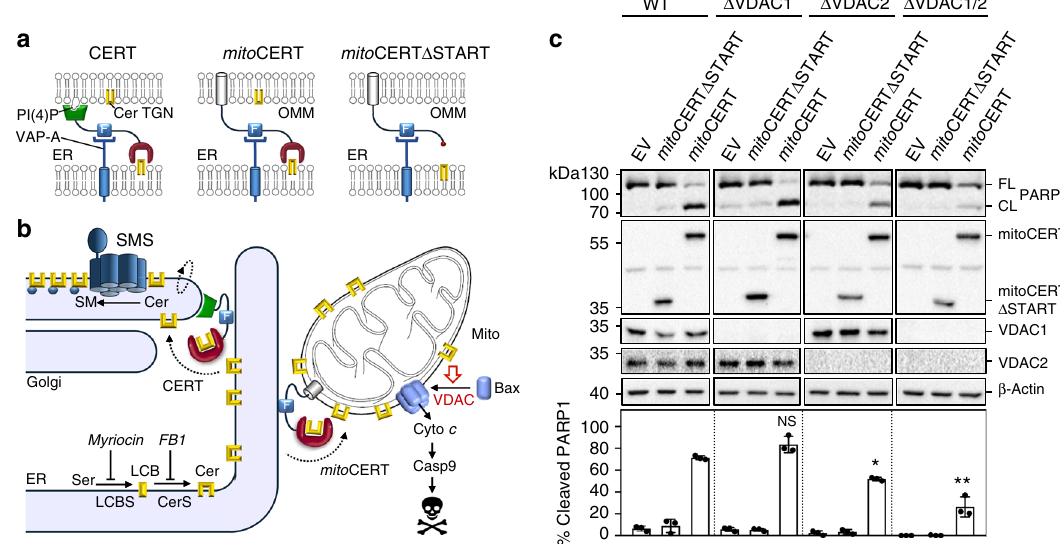
Fig. 6 VDAC2 removal disrupts ceramide-induced apoptosis. a Schematic outline of ceramide transfer protein CERT, mitoCERT, and mitoCERT Δ START. MitoCERT was created by swapping the Golgi-targeting pleckstrin homology domain of CERT against the OMM anchor of AKAP1. Removal of the ceramide transfer or START domain yielded mitoCERT Δ START. All three proteins bind the ER-resident protein VAP-A via their FFAT motif (F). Cer ceramide, PI(4)P phosphatidylinositol-4-phosphate, TGN trans -Golgi network. b Ceramides (Cer) are synthesized through N-acylation of long chain bases (LCB) by ceramide synthases (CerS) on the cytosolic surface of the ER and require CERT-mediated transfer to the Golgi for metabolic conversion into sphingomyelin (SM) by a Golgi-resident SM synthase (SMS). Expression of mitoCERT causes a diversion of this biosynthetic ceramide fl ow to mitochondria, triggering Bax-dependent apoptosis 11 . c Wild type (WT), VDAC1-KO ( Δ VDAC1), VDAC2-KO ( Δ VDAC1), and VDAC1/2 double KO ( Δ VDAC1/2) human colon cancer HCT116 cells were transfected with empty vector (EV), Flag-tagged mitoCERT, or Flag-tagged mitoCERT Δ START. At 24 h post transfection, cells were processed for immunoblotting with antibodies against PARP1, the Flag-epitope, VDAC1, VDAC2, and β -actin. The percentage of PARP1 cleavage was quanti fi ed. Data are means± s.d.; n = 3; * p < 0.05 and ** p < 0.01 by two-tailed paired t -test. Source data